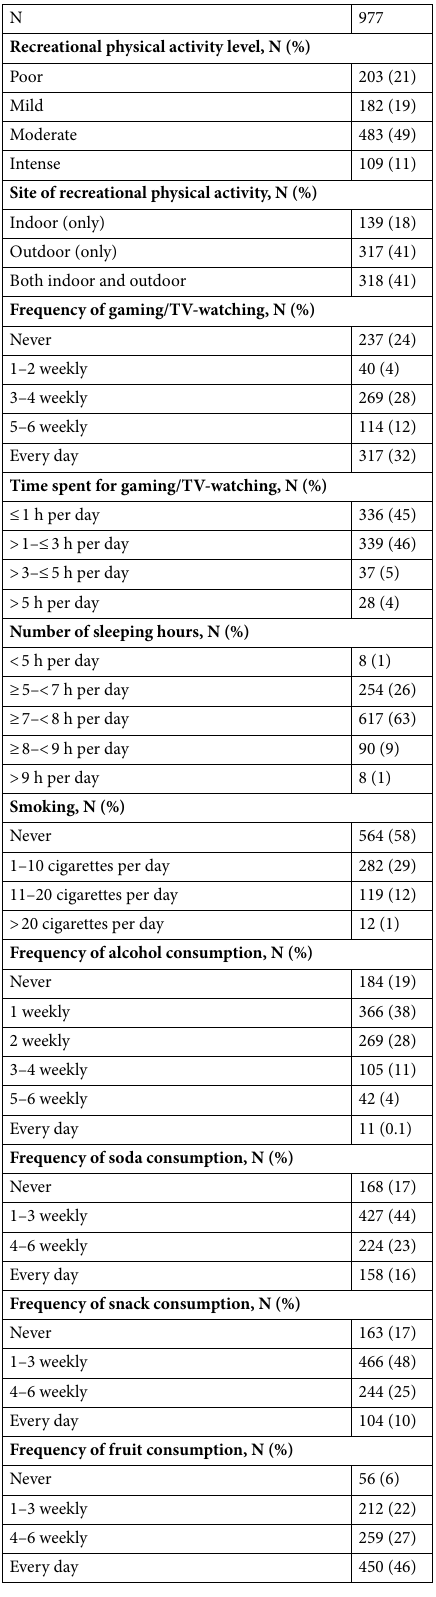
Table 2. Lifestyle characteristics of the 977 enrolled subjects. Data are given as absolute frequency and